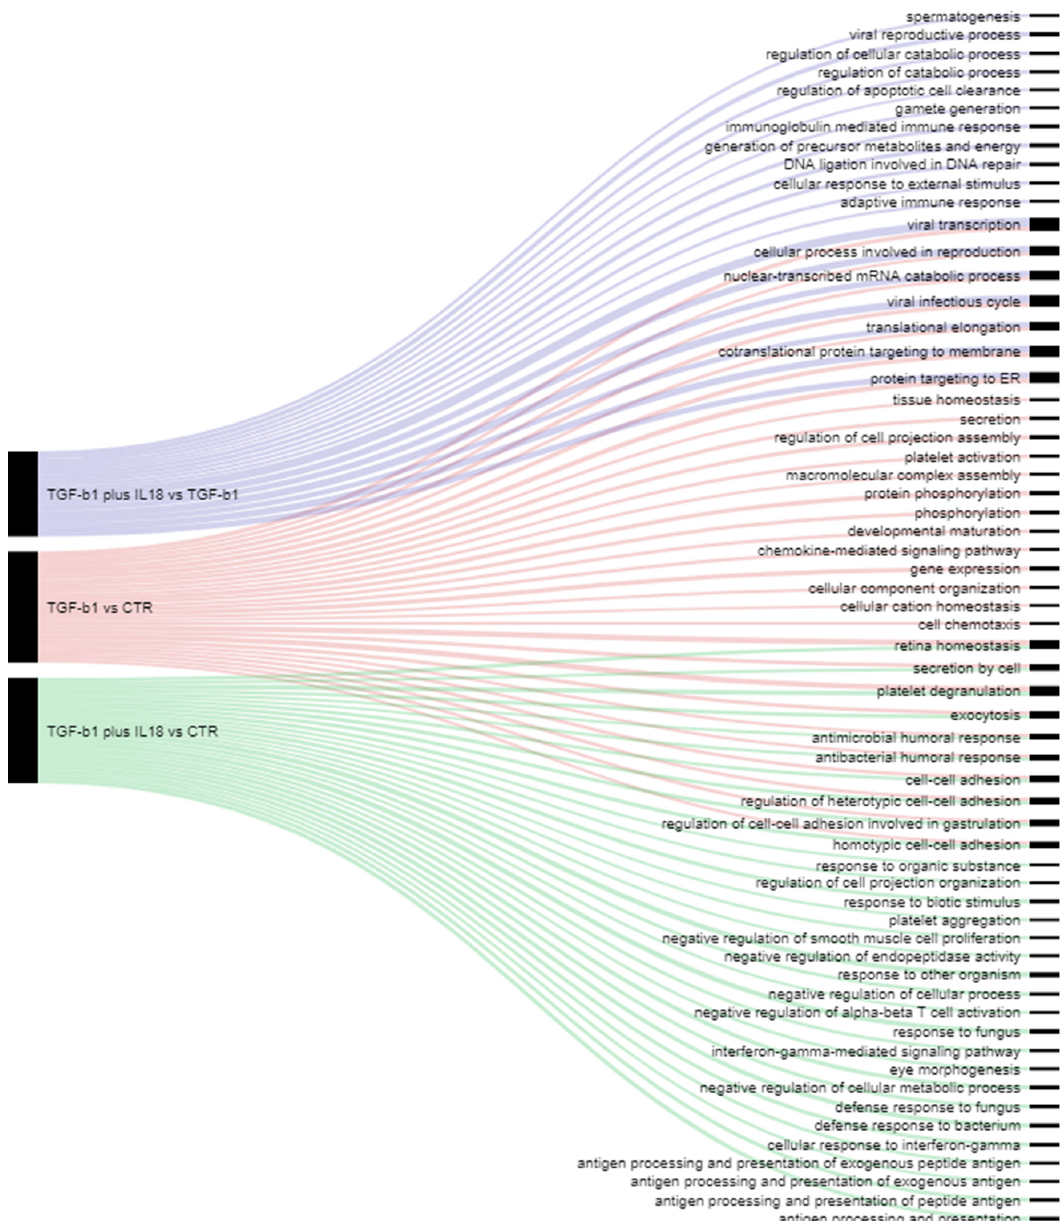
Figure 5. Profile plot of 1D annotation enrichment results. Enrichment is done by GOBP downloaded from Uniprot with a significance threshold of p < 0.001. The output file is converted into a Sankey plot where different colors are associated with different data sets and the width of flow line for each biological process is related to − log10 ( p -value) of the enrichment.